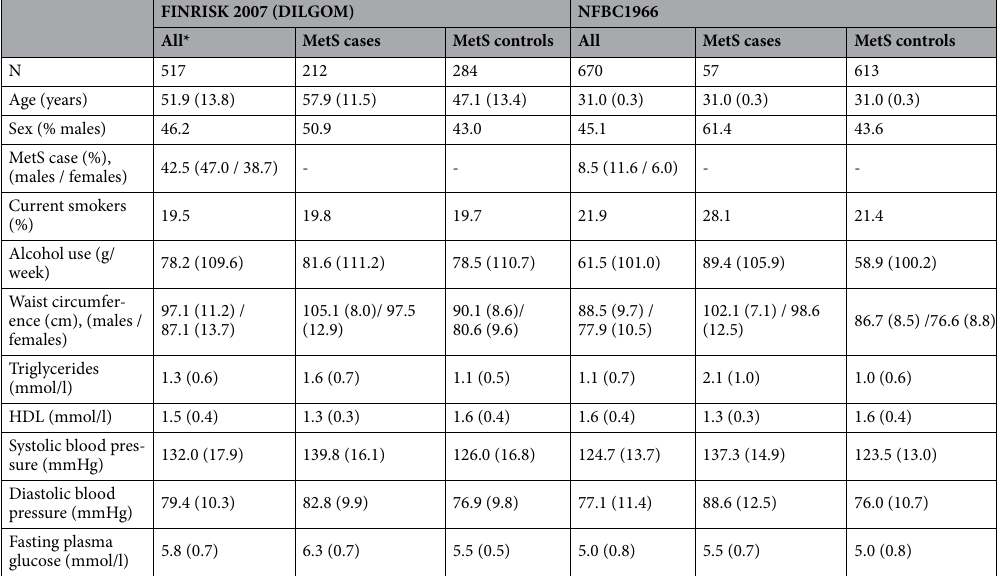
Table 1. Sample characteristics. Data is given as mean (SD) or %. DILGOM dietary, lifestyle, and genetic determinants of obesity and metabolic syndrome, NFBC1966 Northern Finland Birth Cohort 1966, MetS metabolic syndrome, HDL high-density lipoprotein. *The number of study participants in DILGOM refers to the individuals for whom methylation data were available. Sample sizes vary between analysed traits as described in Supplementary